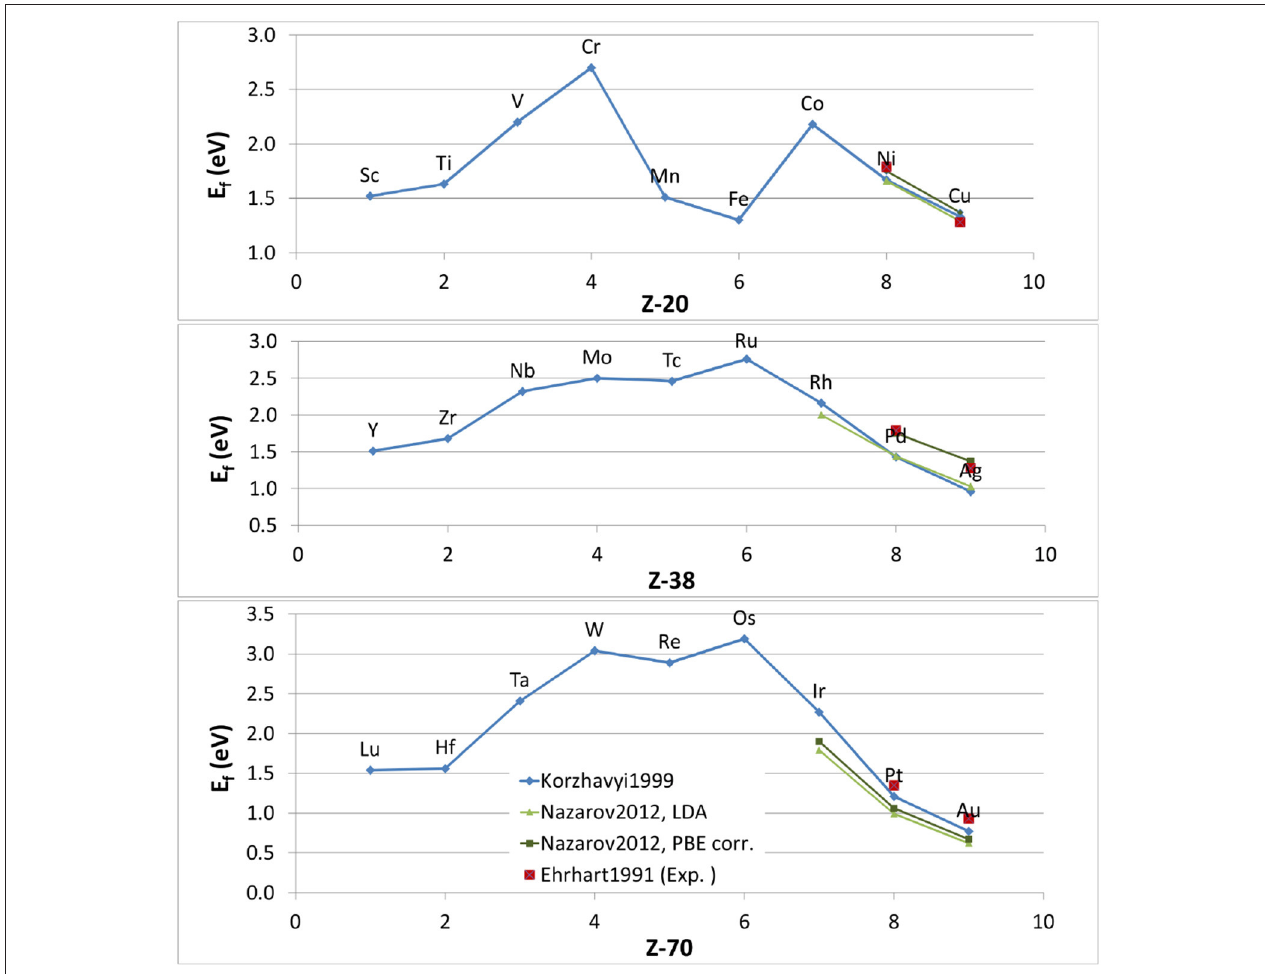
FIGURE 2 | Vacancy formation energies of 3d (upper panel), 4d (central panel) and 5d (lower panel) transition metals as a function of atomic number (Z) as obtained from theory. The blue diamonds are taken from Korzhavyi et al. (1999), the light green triangles are data obtained with LDA from Nazarov et al. (2012), the dark green squares are from the same reference, but include a correction for describing the vacancy internal surface. The experimental values for some late transition metals (Ehrhart et al., 1991) (red squares) are